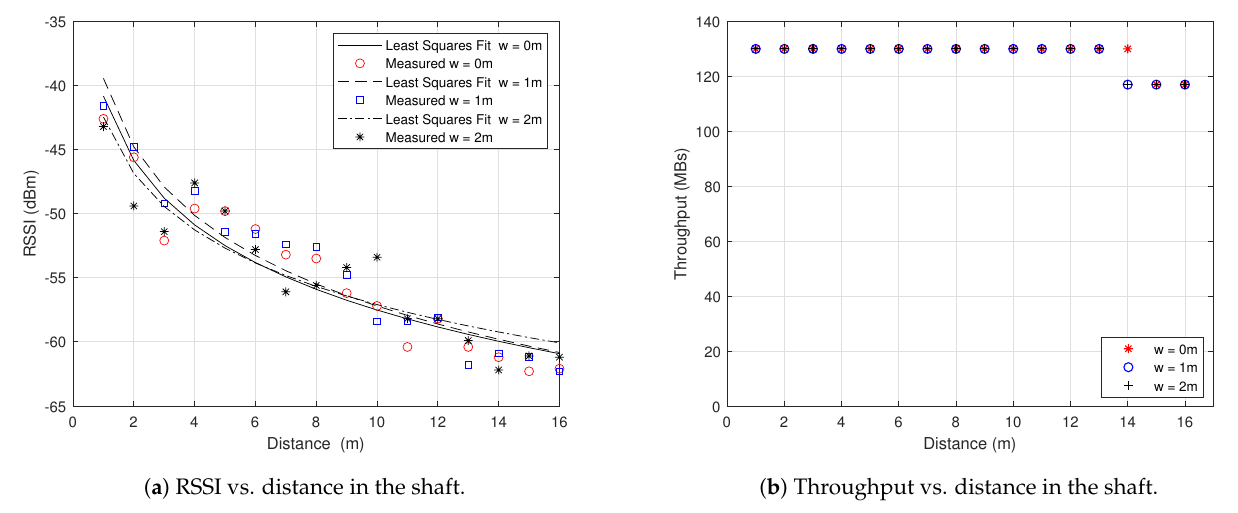
Figure 8. RSSI and throughput obtained at distance points in the shaft. As observed in Figure 9a,b, the RSSI values of the transmitter positioned at the edges of the measurement areas show stronger received signal power as the receiver moves away from the transmitter. This is in comparison with the transmitter positioned at the centre of the measurement areas. Furthermore, some regions, such as 54–59 m in the tunnel, show stronger RSSI values compared with the 30–40 m shorter distance. Since the 54–59 m region is closer to the end of the tunnel, which contains steel gates, higher RSSI values in this region may be attributed to multipath reflections in that region.